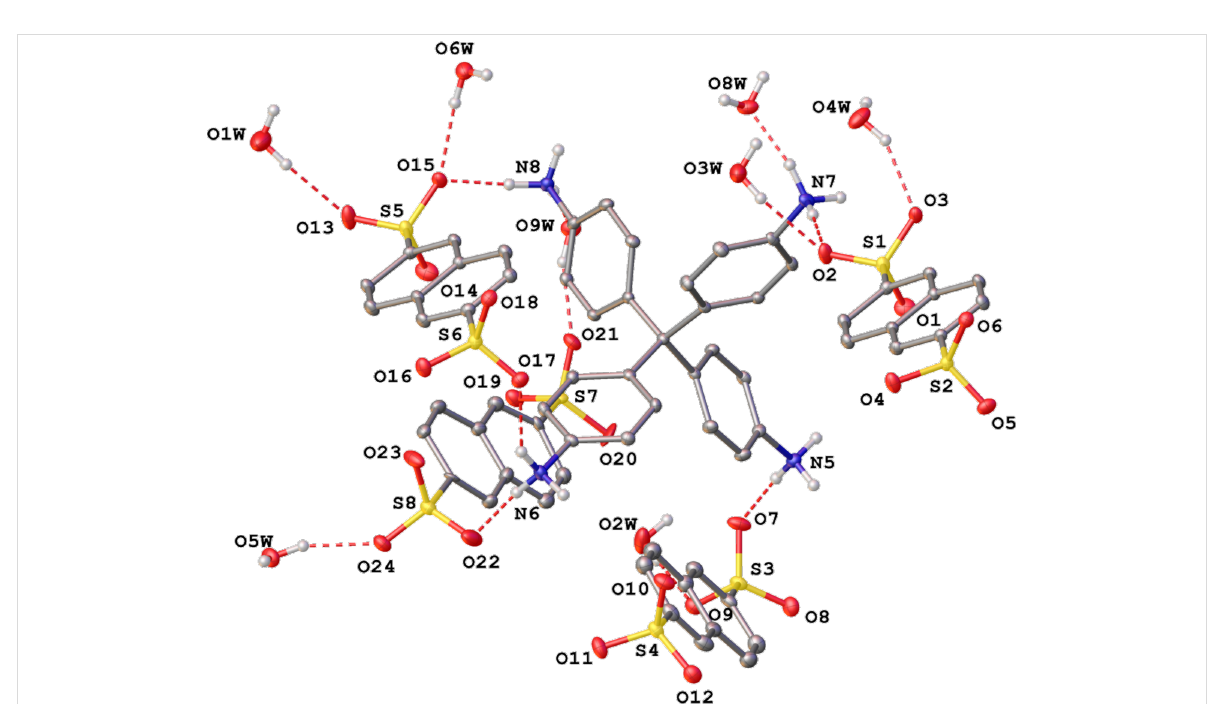
Figure 1: View of the crystal structure of F-1 ( F-1a phase), with representation of atoms by thermal ellipsoids at a 30% probability level. The hydro- gen atoms, except for those in NH groups and solvate water molecules, were omitted for clarity. Only the labels of symmetry-independent heteroatoms are